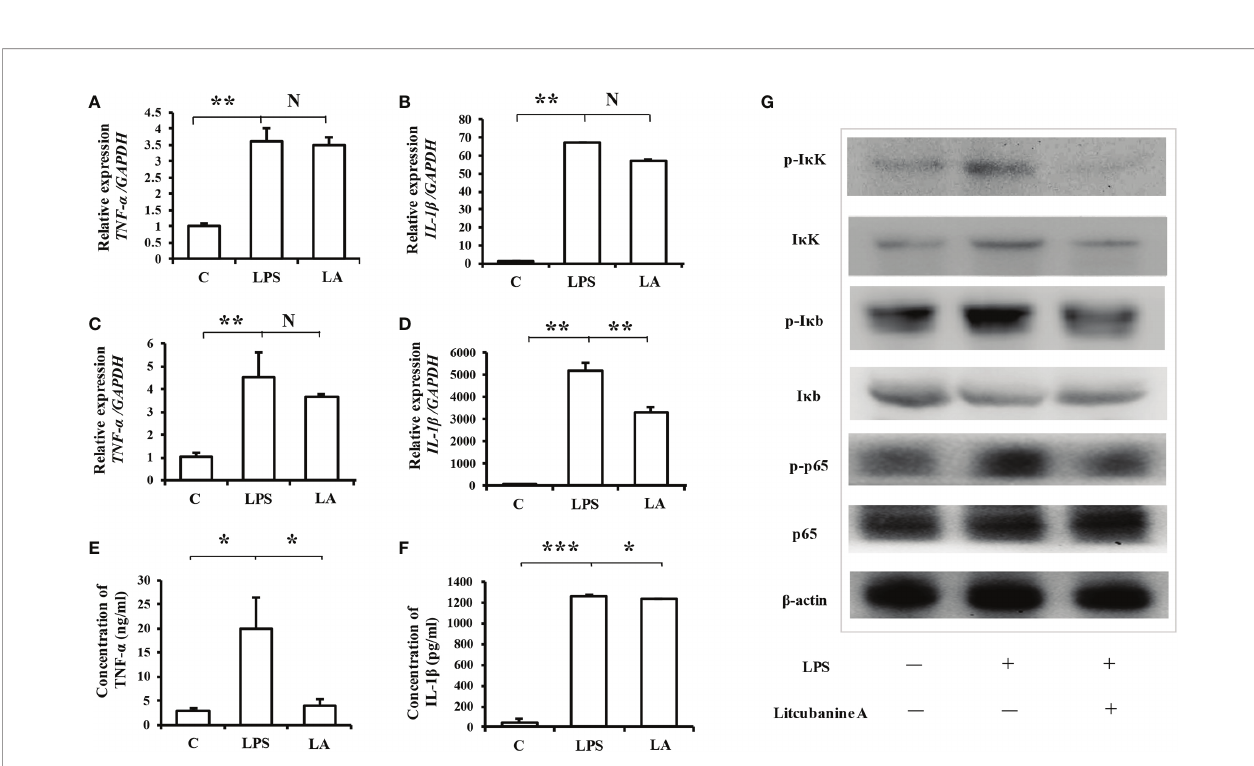
FIGURE 6 | Treatment with LA inhibits the expression of in fl ammatory factors induced by LPS via the NF- k B pathway (A, B) Real-time PCR analysis showing that in peritoneal macrophages, the up-regulation of TNF- a and IL-1 b after LPS treatment can be inhibited by treatment with 100 nM LA (n=3). (C, D) Treatment with LA also inhibited TNF- a and IL-1 b mRNA expression levels in RAW264.7 macrophages (n=3). (E, F) ELISA results con fi rming that LPS treatment promotes the expression level of TNF- a and IL-1 b , which is decreased by treatment with LA in RAW264.7 macrophages (n=3). (G) Western blot showing that LPS treatment increases the protein expression levels of p-I k K, p-I k b and p-p65. In contrast, treatment with LA inhibits the upregulation of those proteins induced by LPS. All results are representative of at least three independent experiments/samples. Results are expressed as means ± standard deviation (SD), and statistical signi fi cance is shown as N P > 0.05, *P < 0.05, **P < 0.01, ***P < 0.001.